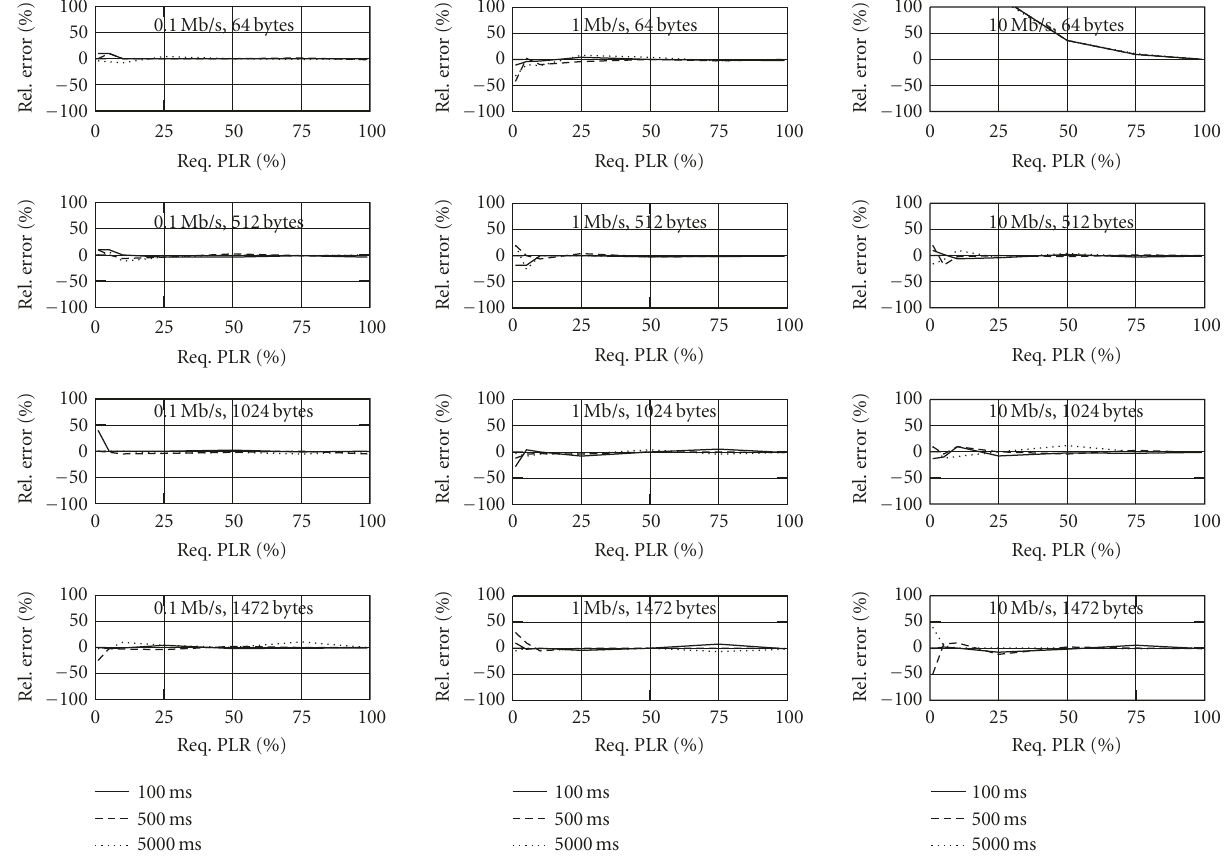
Figure 21: Relative packet loss accuracy error.